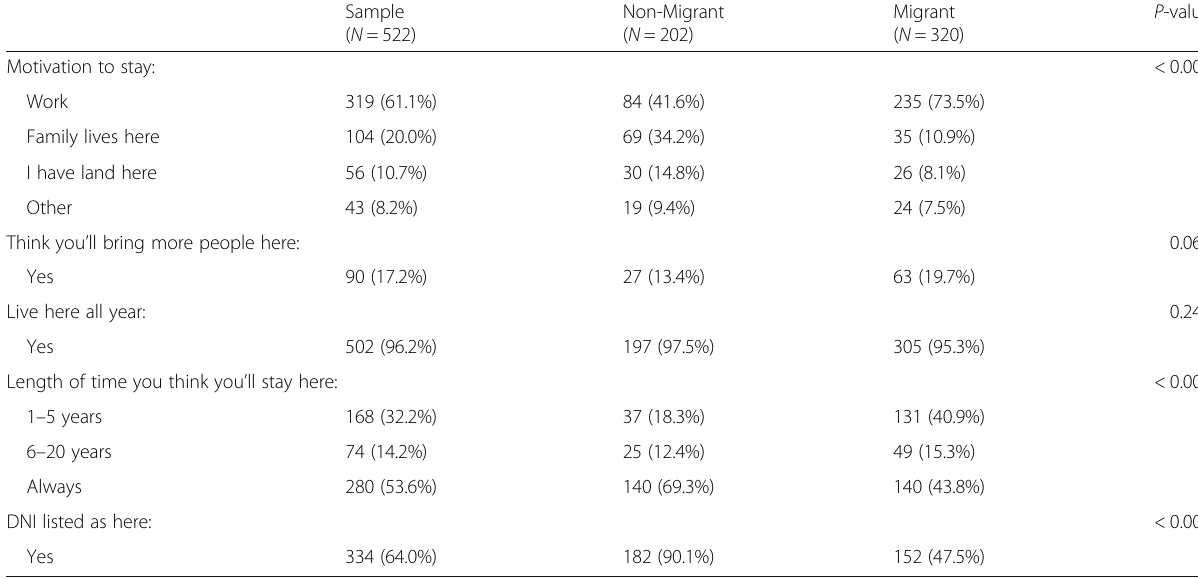
Table 9 Social Capital: Reasons to stay